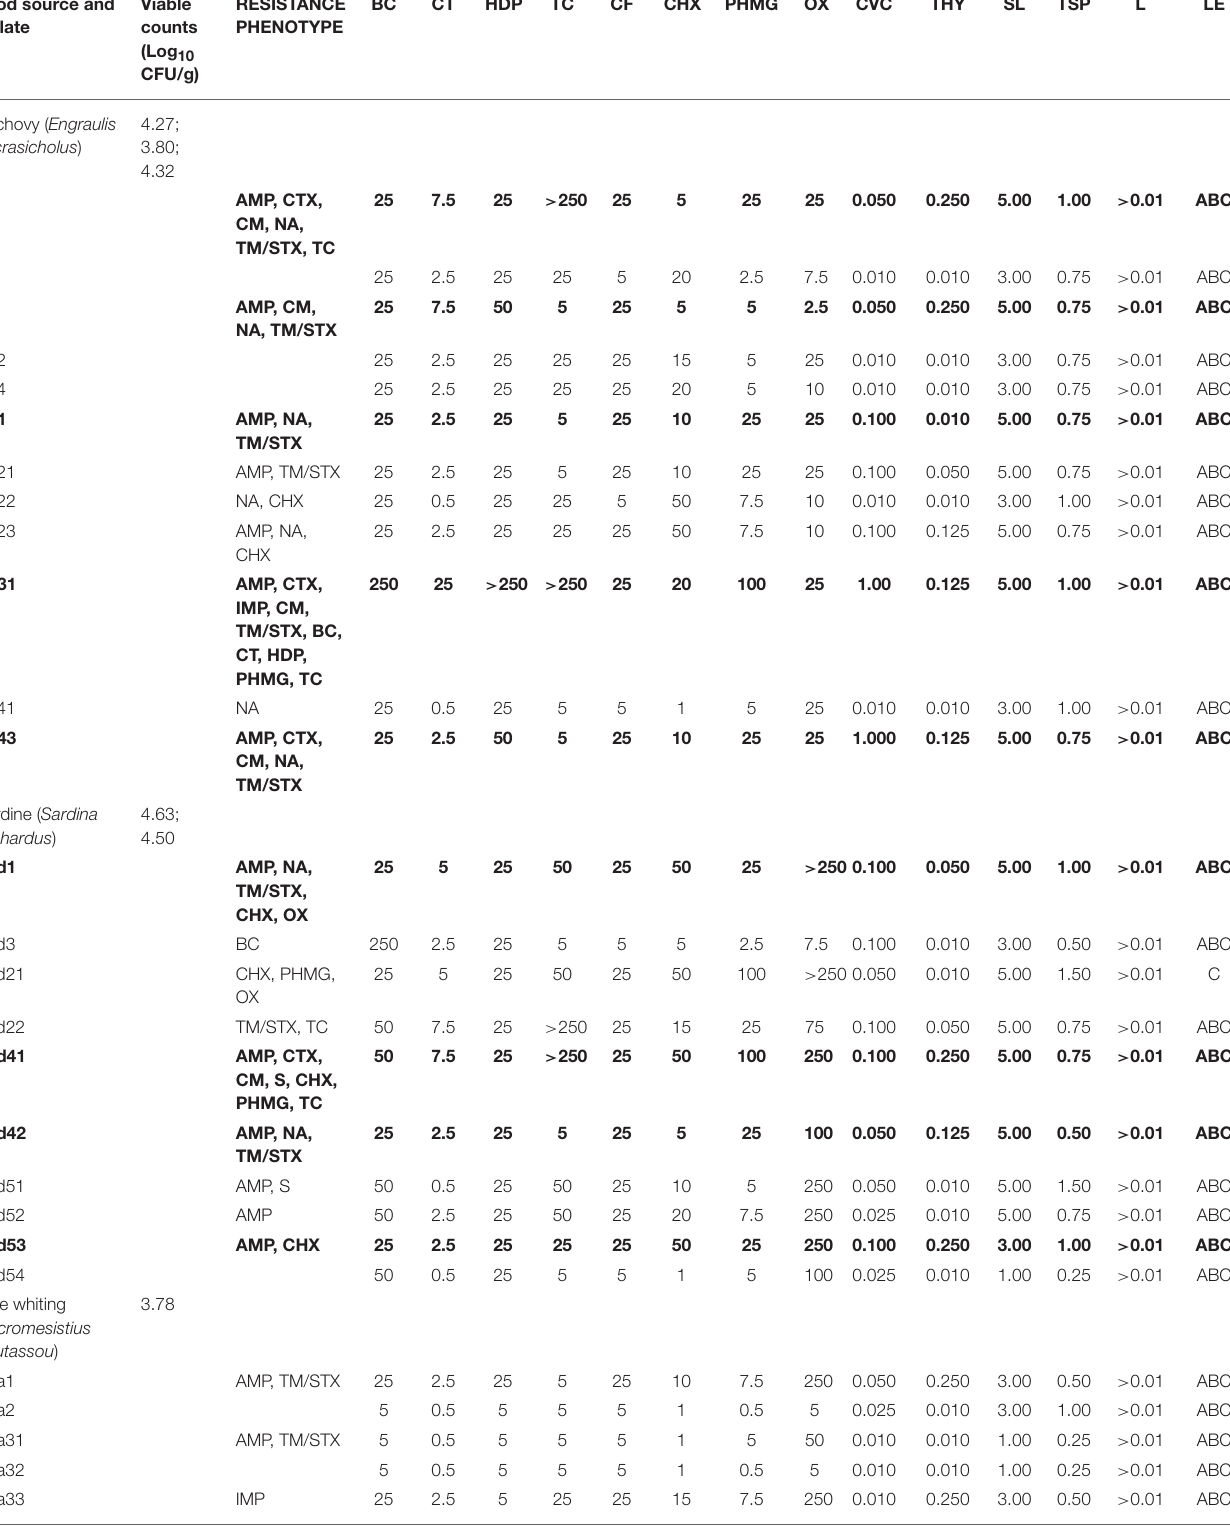
TABLE 1 | Sensitivity to antibiotics, biocides and other antimicrobials in bacterial isolates recovered from seafoods. Food source and